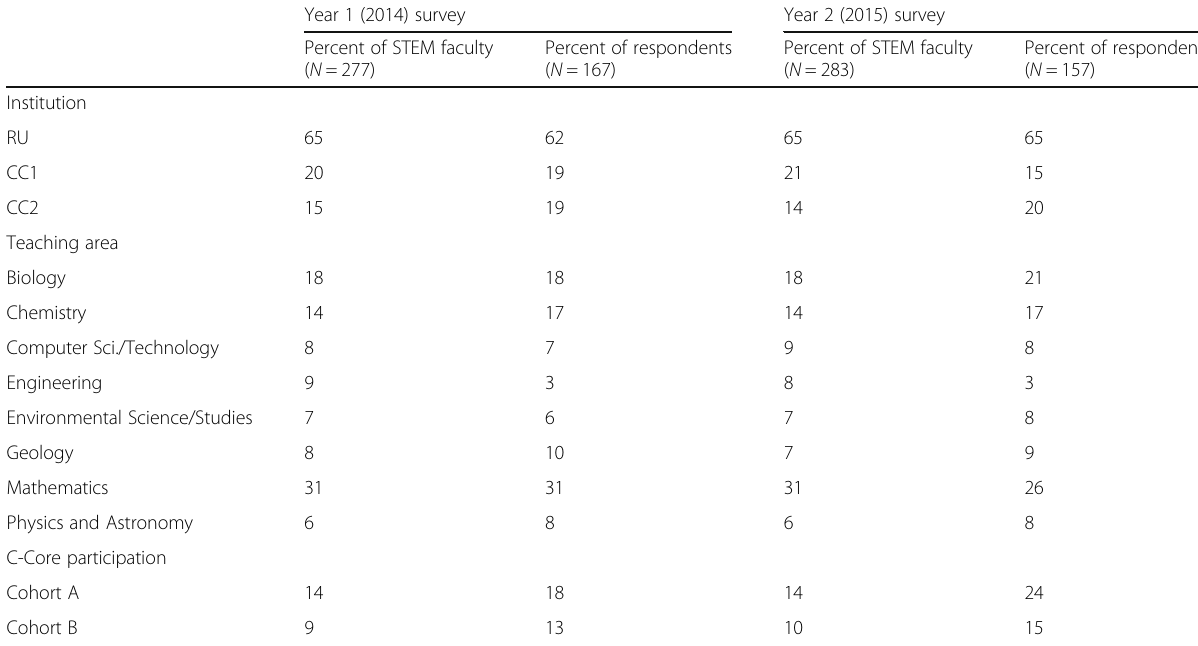
Table 2 Characteristics of external evaluation survey